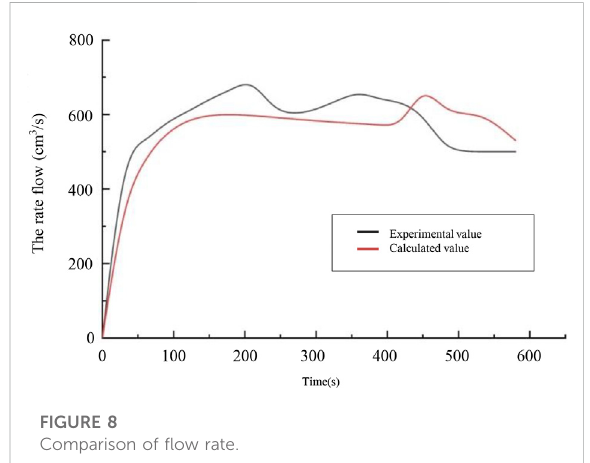
FIGURE 8 Comparison of fl ow rate.